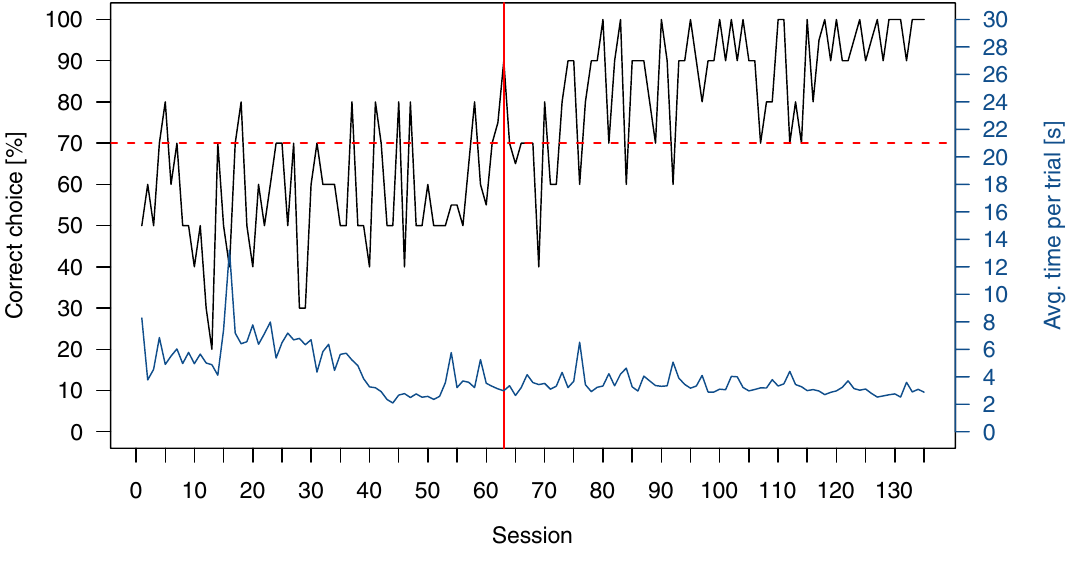
Figure 6. Exemplary graph of the performance of a stingray during the entire training and testing (overtraining) phase. The black line shows the percentage of correct choices per ten-trial session. The horizontal red dotted line indicates the lower limit of the LC, while the vertical red line indicates the time when the LC was achieved. In the sessions following the red vertical line, transfer tests were added to the regular ten trial session. The blue line gives the average trial time for each session.